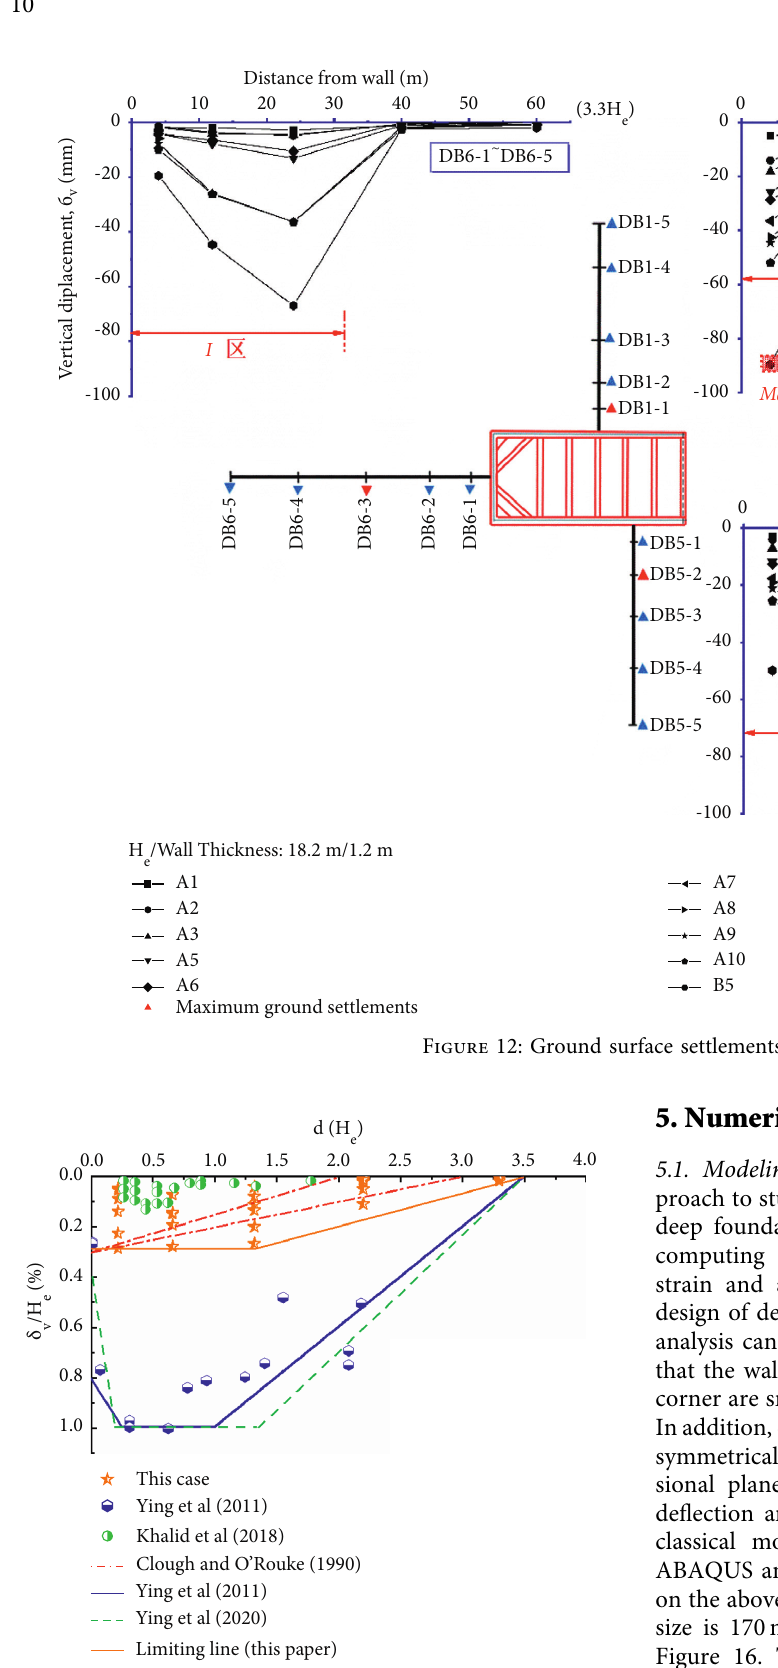
Figure 13: Relationship between the relative settlement and the normalized distance from the